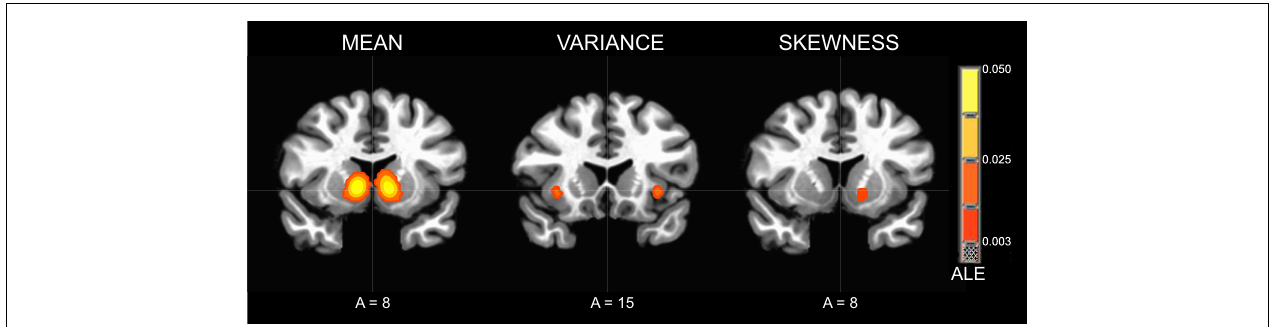
FIGURE 3 |Activation Likelihood Estimate (ALE) meta-analytic maps for high versus low mean, variance, and skewness. ALE of mean: bilateral NAcc. ALE of variance: bilateral anterior insula. ALE of skewness: left NAcc.